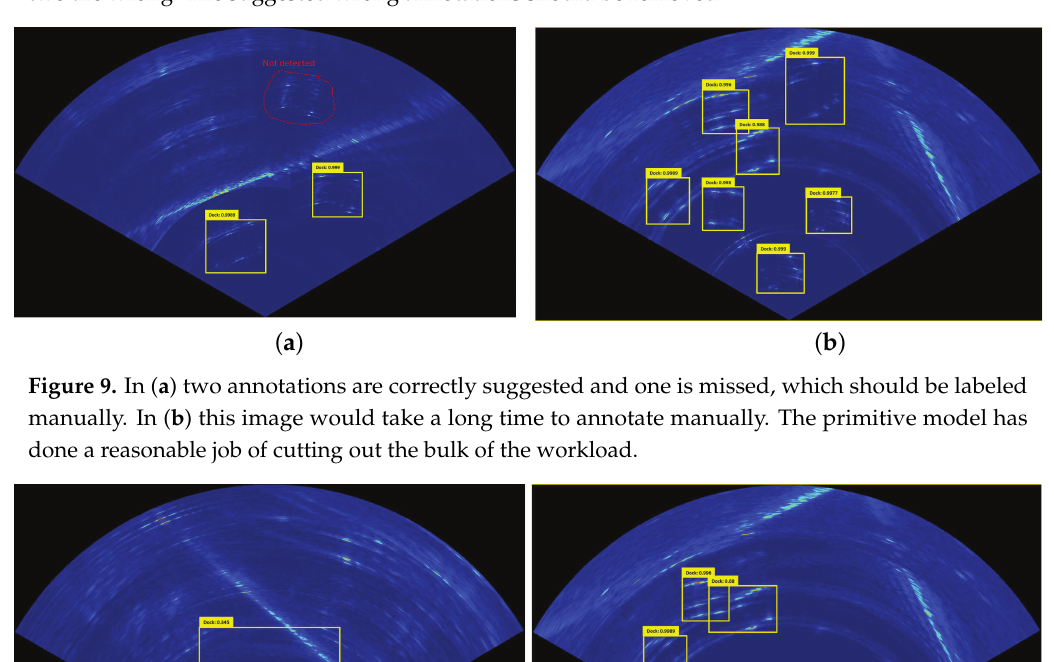
Figure 8. In ( a ) two annotations are suggested and one is wrong. The suggested wrong annotation on the furthest box should be removed manually. ( b ) In this example, three annotations are suggested and two are wrong. The suggested wrong annotations should be removed.